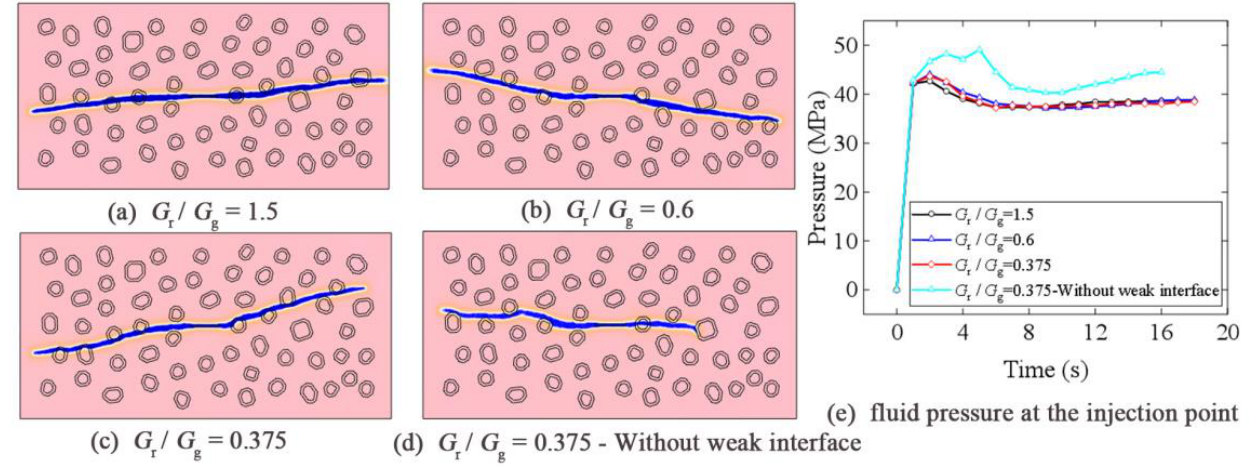
GG . Figure 9. Fracture propagation and pressure curves at injection point for different G r / G g r g